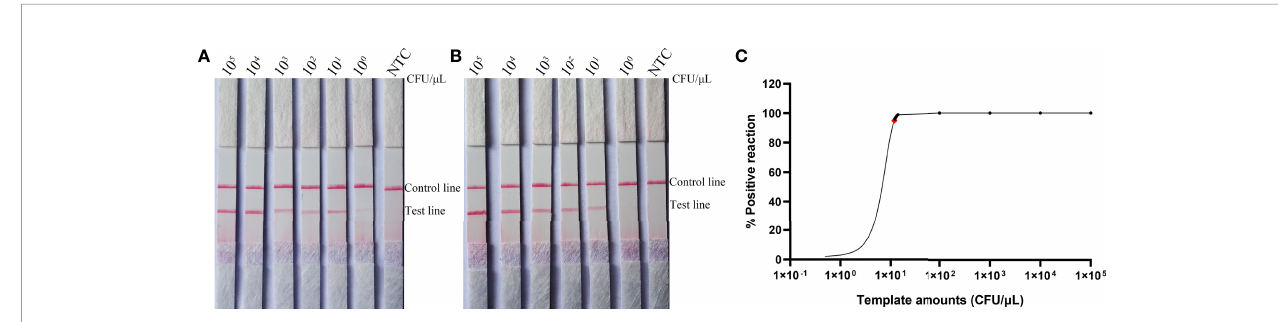
FIGURE 3 | Determination of the lower limit of detection of the C. tropicalis RPA-LFS assay. (A) The lowest limit of detection for the C. tropicalis RPA-LFS assay system established using primer-probe set F5/P/R1B was determined from eight independent assays using inactivating solutions of C. tropicalis with serial dilutions from 10 0 to 10 5 CFU for each reaction. Image shows the results of the RPA-LFS with the number of templates indicated at the top of the bar graph. (B) Image of the results of the RPA-LFS assay using primer-probe set F5/P/R1B and 10 5 CFU of C. albicans as interference. (C) Probit regression analysis was performed on data collected from eight replicates.